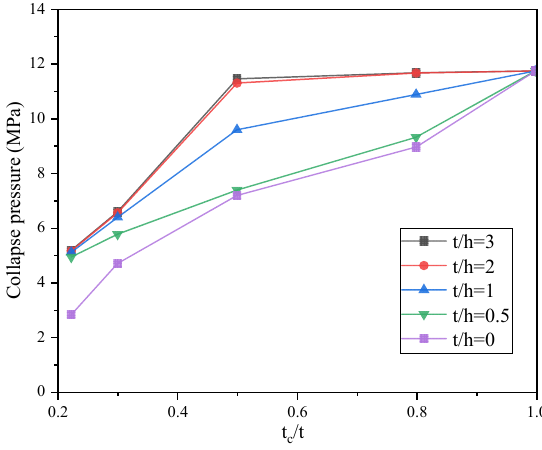
Figure 23. Comparison of the effect of metal loss rate.